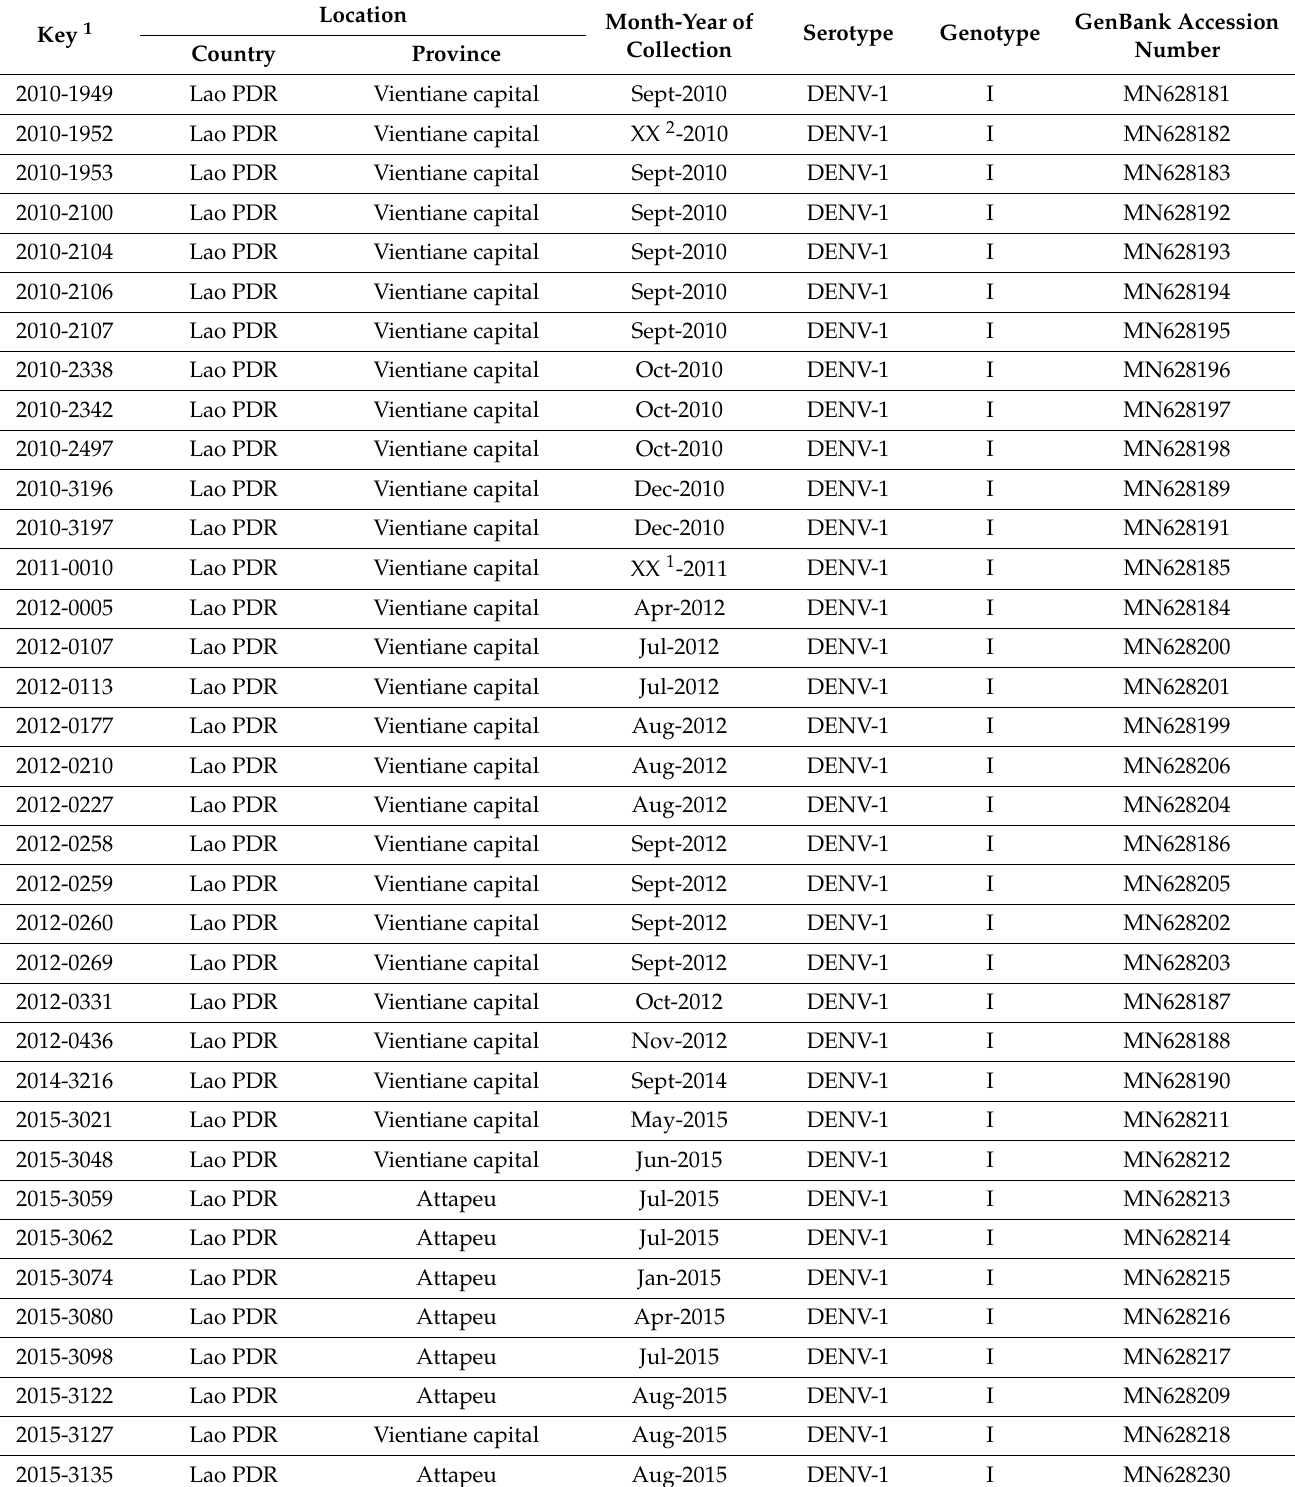
Table 2. List of studied Lao Dengue isolates selected during the longitudinal survey from 2010 to